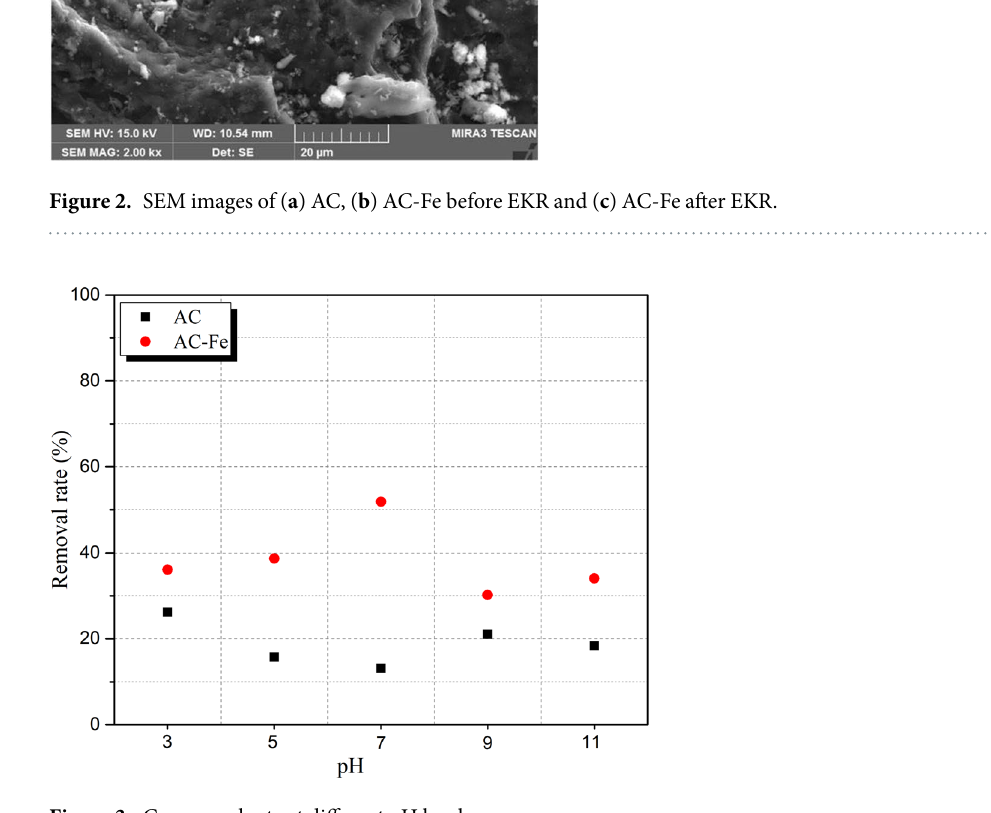
Figure 3. Cr removal rate at different pH